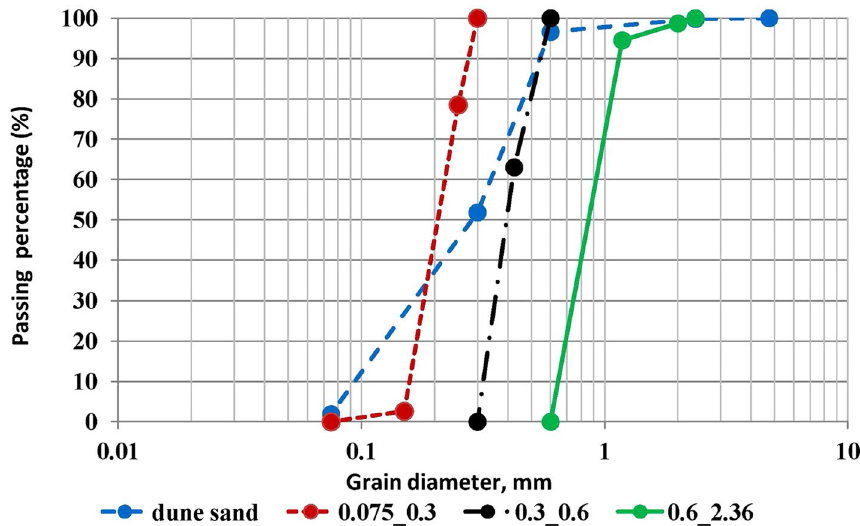
Figure 1. The diagrams of grain distributions of four samples used for the